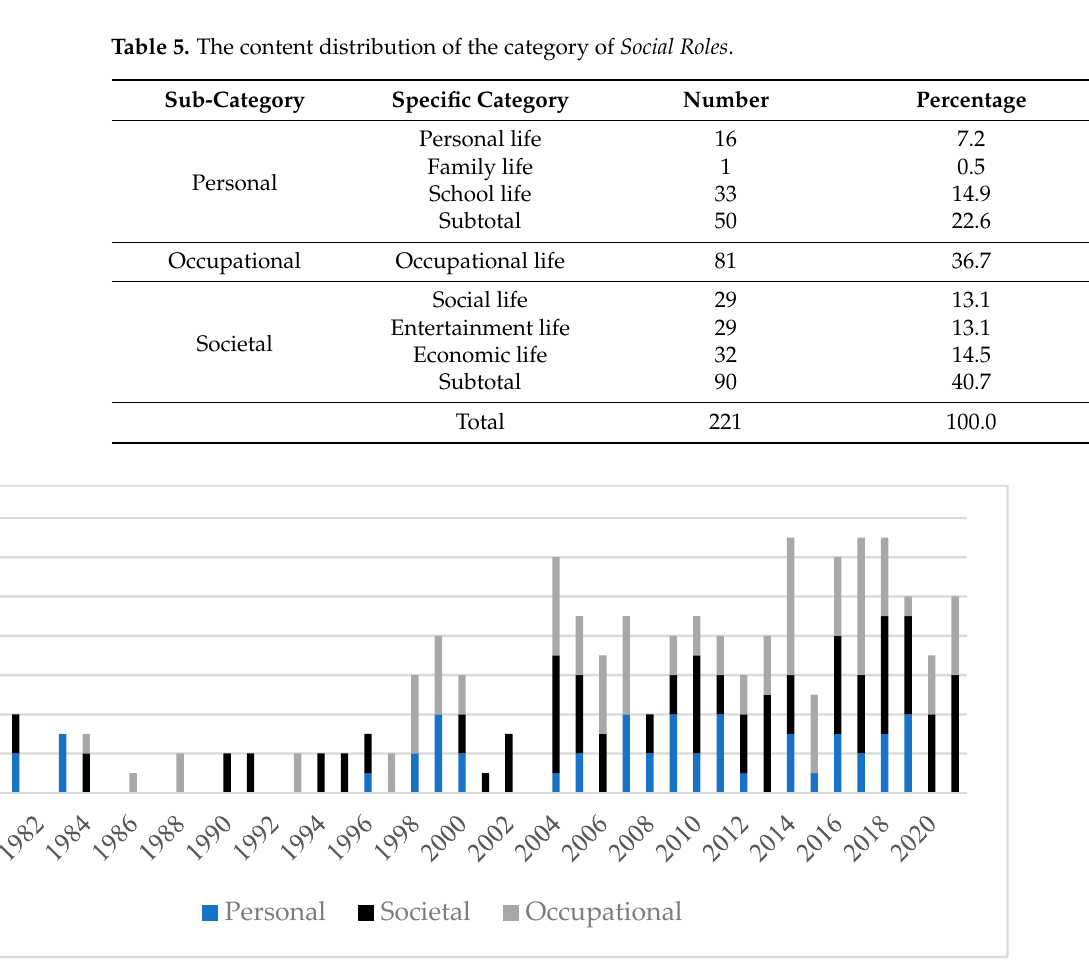
Table 6. The content distribution of the category of Aesthetics & Recreation .